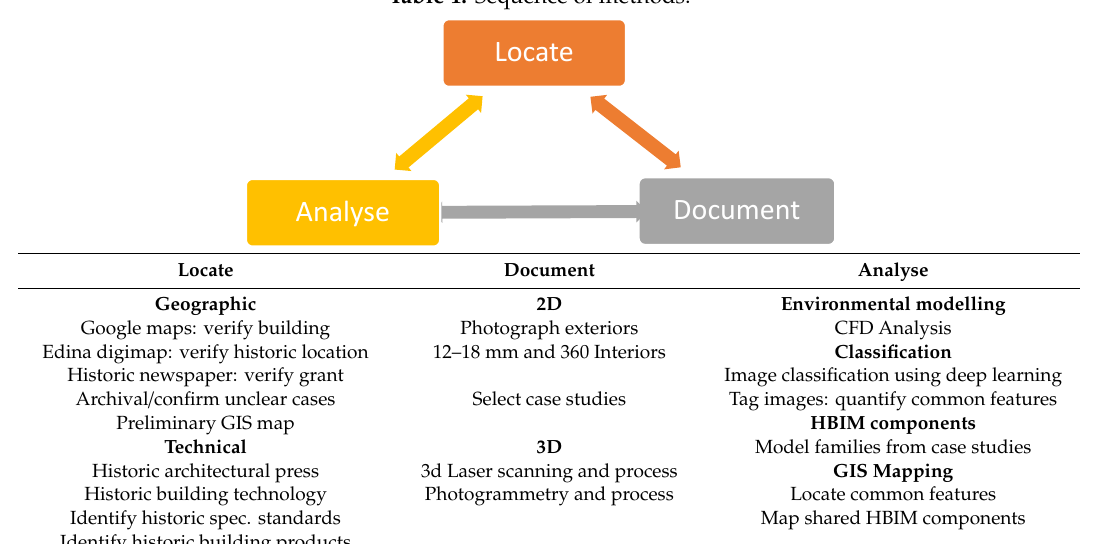
Table 1. Sequence of methods.